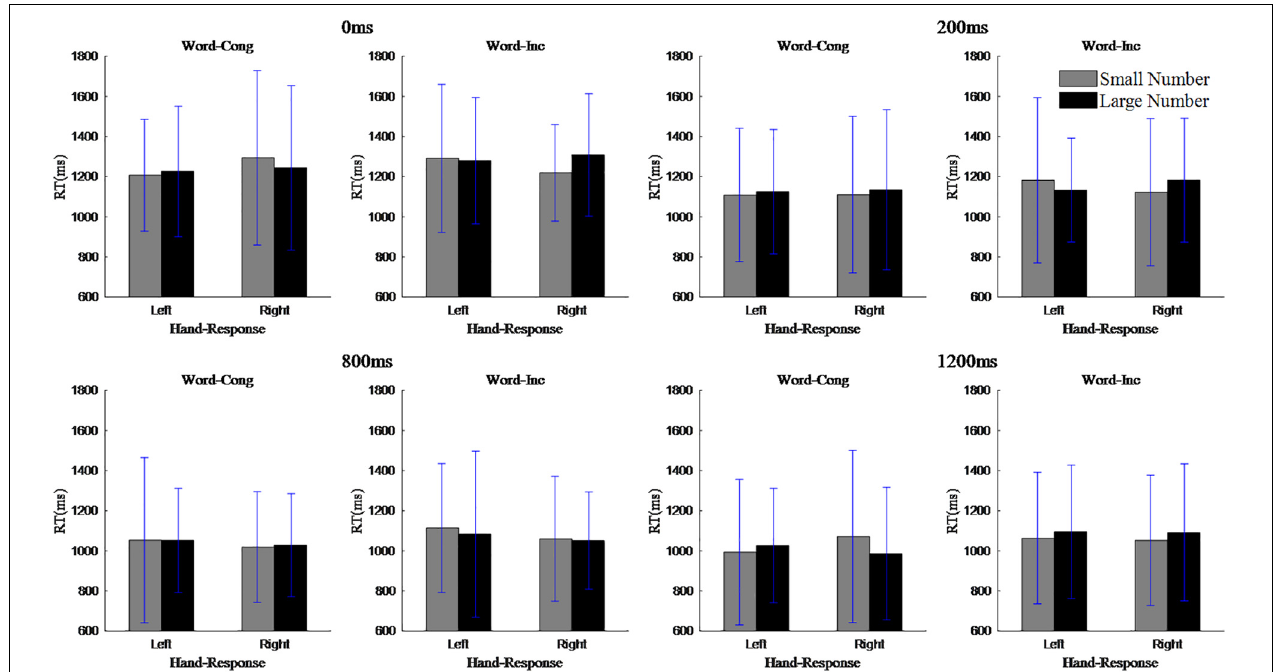
FIGURE 3 | The interaction between magnitude and reaction hand of each stimulus onset asynchrony in the parity judgment task.